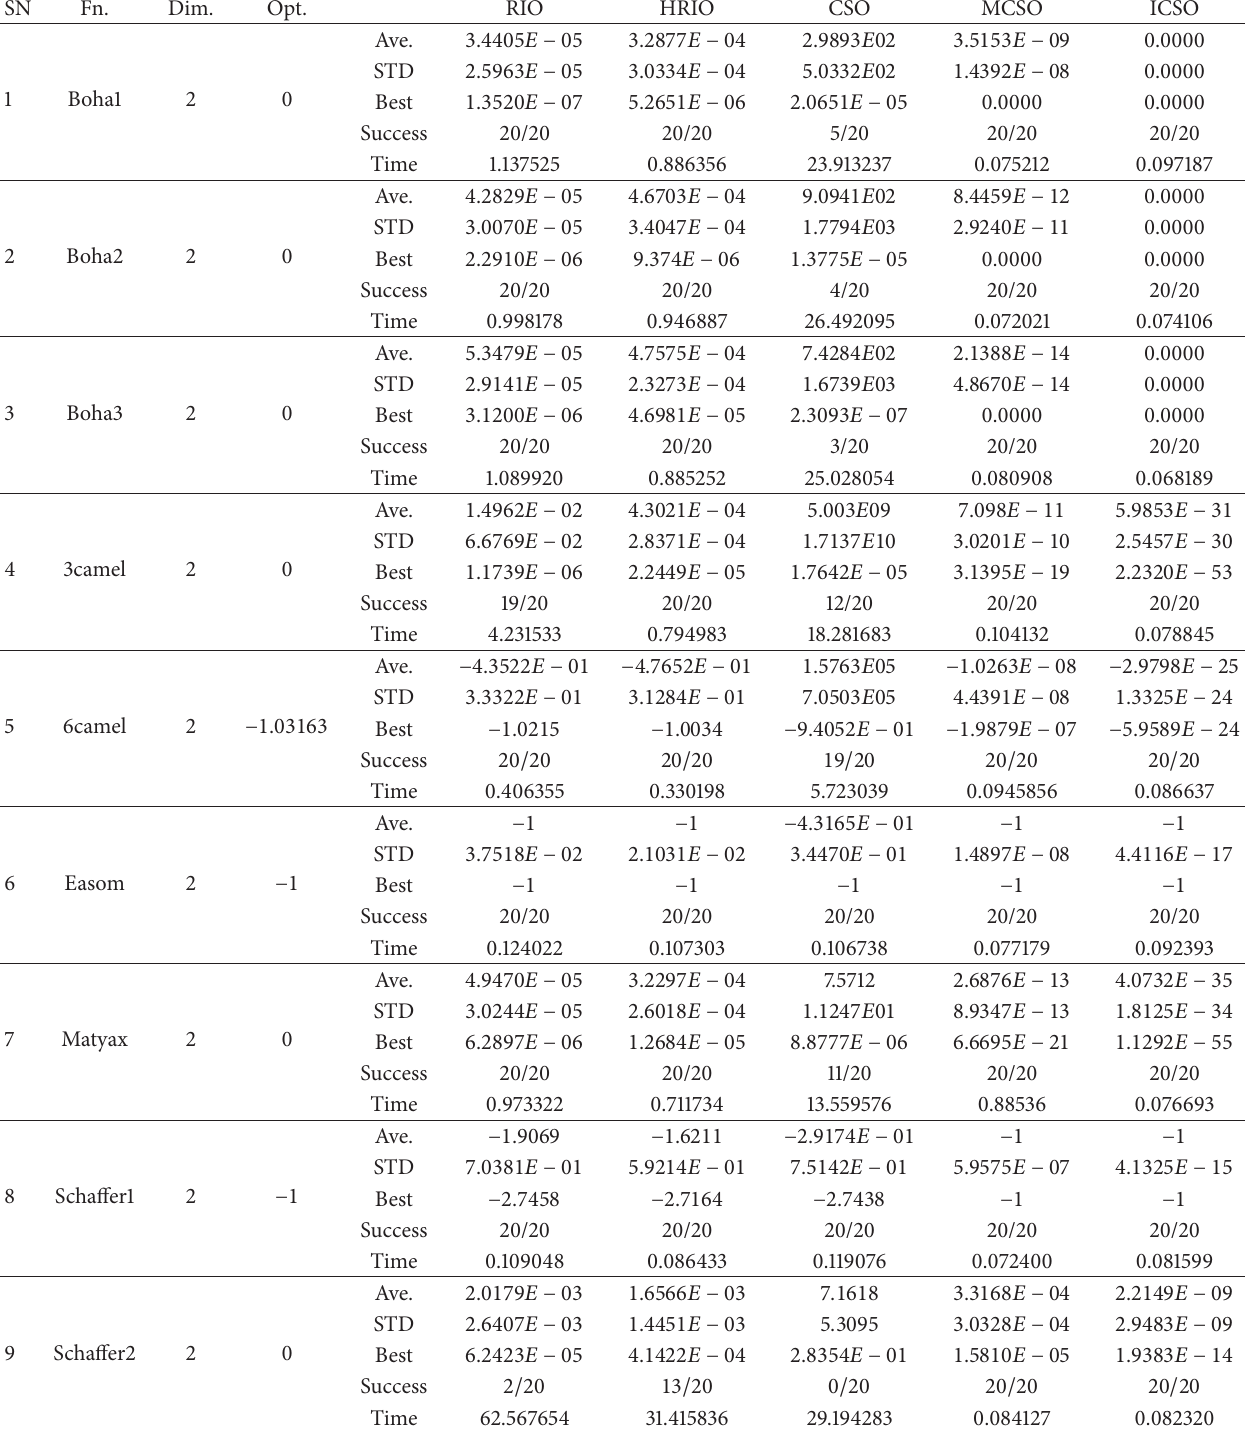
Table 2: Simulation results of RIO, HRIO, CSO, MCSO, and ICSO. SN Fn.